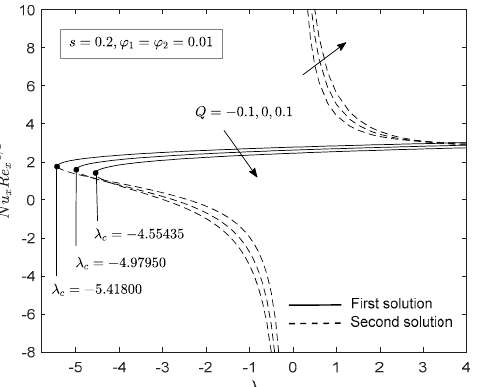
Figure 12. Nu x Re − 1/2 x for selected value of heat generation/absorption when s = 0.2. Nu − for selected value of heat generation/absorption when 0.2 s = . Figure 12 . 1/2 Re x x